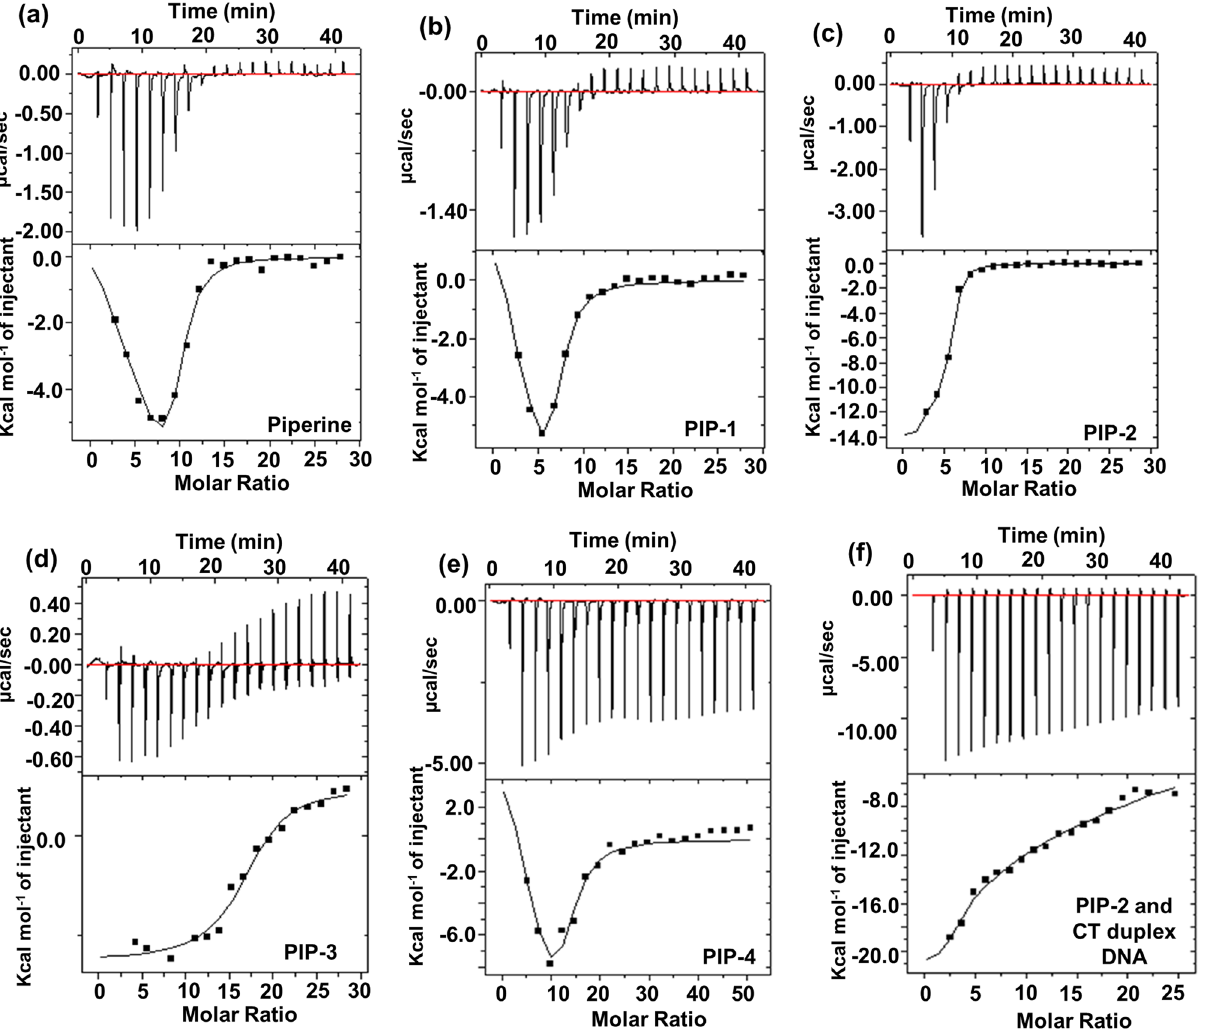
Figure 4. The ITC thermogram of Piperine analogs with c-myc G4 DNA ( a – e ) The upper panel of the ITC profile shows the isothermal titration thermogram of c-myc G4 DNA (in the cell) in (10 mM potassium phosphate buffer containing 50 mM KCl at 25 °C) with various Piperine analogs ( a ) Piperine ( b ) PIP-1 ( c ) PIP-2 ( d ) PIP-3 ( e ) PIP-4 and ( f ) PIP-2 with CT-duplex DNA. The lower panel represents the integrated heat plot of the isothermal calorimetric titration graph depicted in the upper panel. The solid line in the ITC profile represents the best two-modes binding site fitting binding affinity of PIP-2 with c-myc duplex and c-myc mutant G4 DNA was also examined, and it was observed that PIP-2 exhibits ~ 10 4 fold higher affinity with the c-myc G4 DNA than both these controls (Supplementary Fig. S7 and Table S5b). The binding data from both fluorescence and ITC experiment indicate that c-myc G4 DNA contains two bind- ing sites with a single DNA motif via 1:2 binding ratio. The obtained K d1 represents the preferential binding site. On the other hand, K d2 represents the secondary binding site. Hence, the results obtained from the secondary screening through ITC encourage us to proceed further to access the specificity of these potential lead Piperine analogs with c-myc G4 DNA. Study of interaction of Piperine analog PIP-2 with c‑myc G4 DNA using fluorescence emission spectroscopy. Our preliminary screening found that Piperine analog PIP-2 showed a higher binding affin- ity with c-myc G4 DNA. Therefore, to further insights the interaction of PIP-2 with c-myc DNA were evaluated by using fluorescence emission spectroscopy. The concentration of Piperine analogs PIP-2 (5 µM) was kept con- stant throughout the experiment. The highest emission peak of Piperine analog PIP-2 was observed at 400 nm upon excitation at 350 nm. The incremental addition of c-myc G4 DNA causes a significant enhancement in the emission peak (hyperchromic shift) of PIP-2. This increase in the emission spectra indicated the conjugation of PIP-2 with the c-myc G4 DNA, thereby highlighting the ligand’s strong interaction with the G-quadruplex DNA and indicates the protection of ligand by the quenching effect of a polar solvent (Supplementary Fig. S8) 122,123 .